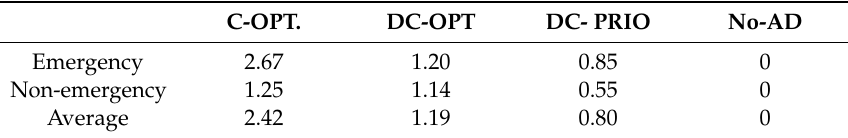
Table 4. Average diversion time of patients in the four models (unit: min).